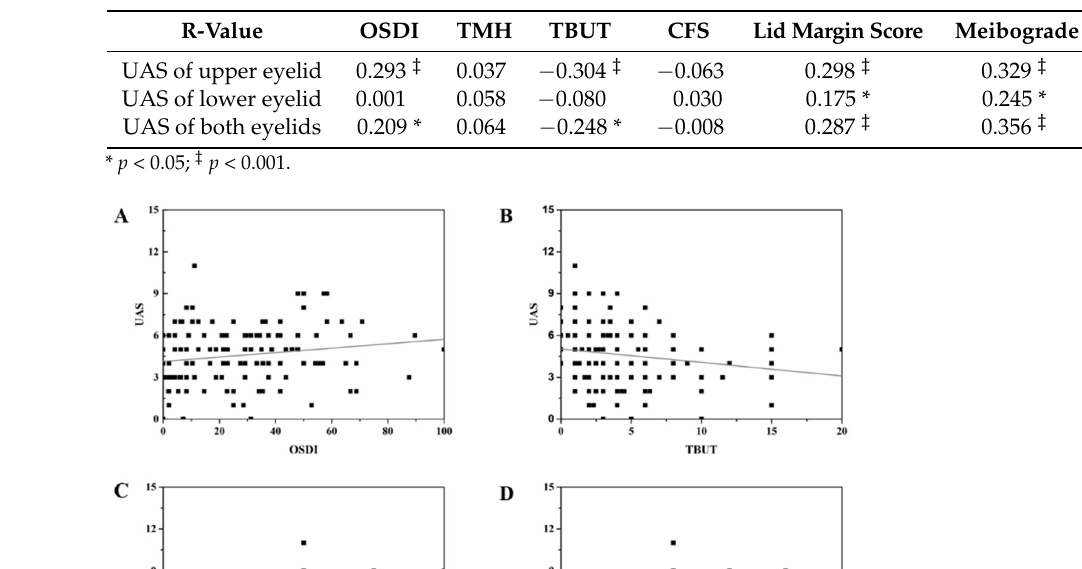
Table 4. Correlation analysis between UAS and ocular surface parameters.